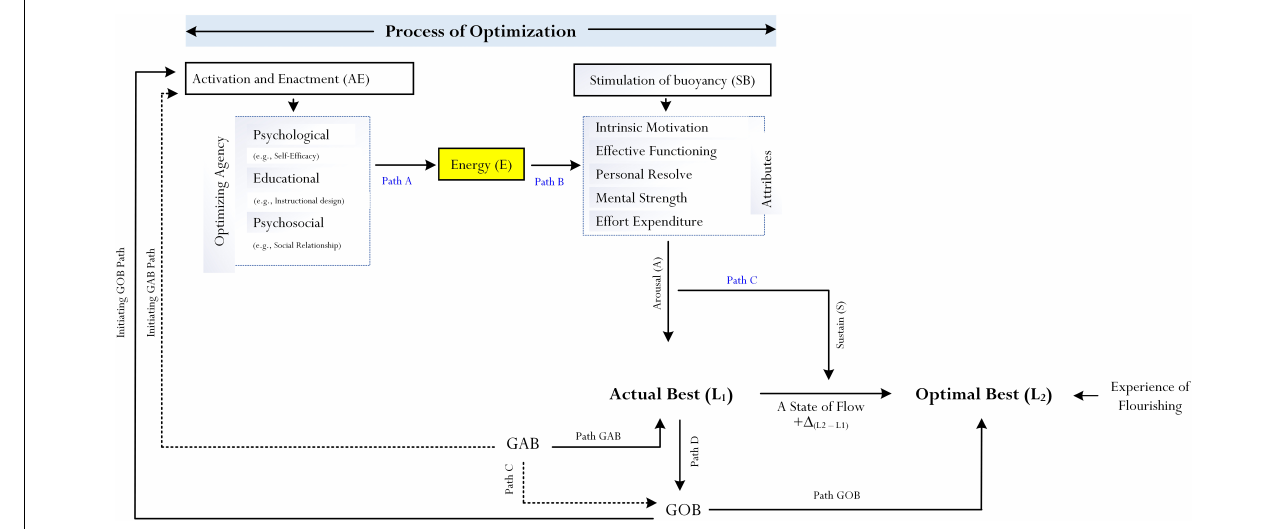
FIGURE 1 | Conceptualization of flow, flourishing, and best practice. Adapted from Phan et al.